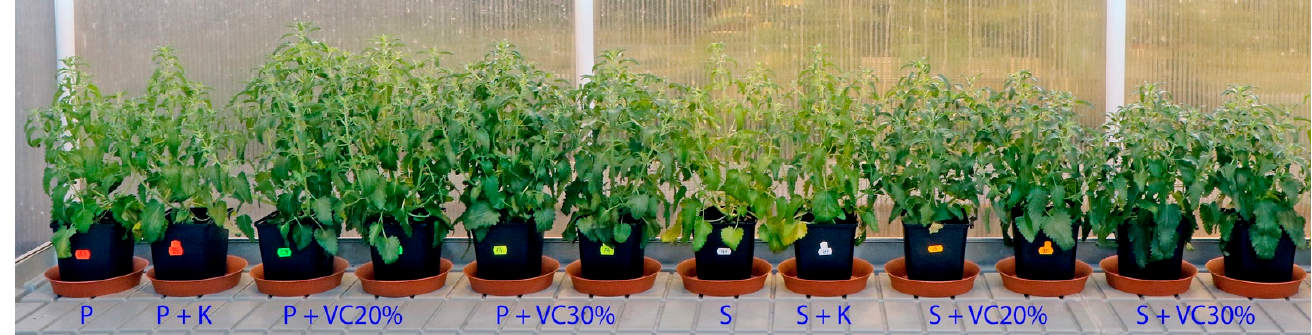
Figure 3. Morphology of the typical average Dracocephalum moldavica grown in different substrates for 8 weeks. P, peat substrate; K, mineral fertilizer Kristalon; VC20%, 20% ( v / v ) vermicompost; VC30%, 30% ( v / v ) vermicompost; S, commercial garden soil.